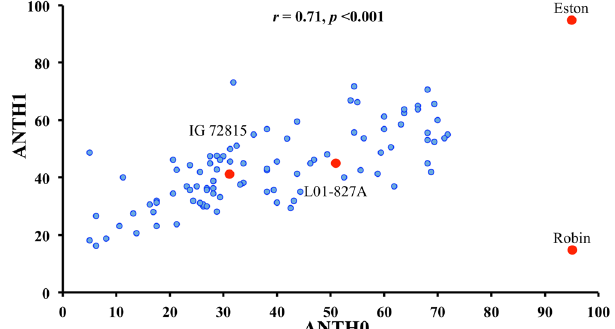
Figure 2. Correlation of disease reactions in the Lens ervoides recombinant inbred line population LR-66 developed from L01-827A × IG 72815 (F 9 ) after inoculation with Colletotrichum lentis isolates CT-30 (race 0, X-axis) and CT-21 (race 1, Y-axis). r = Pearson’s correlation coefficient.